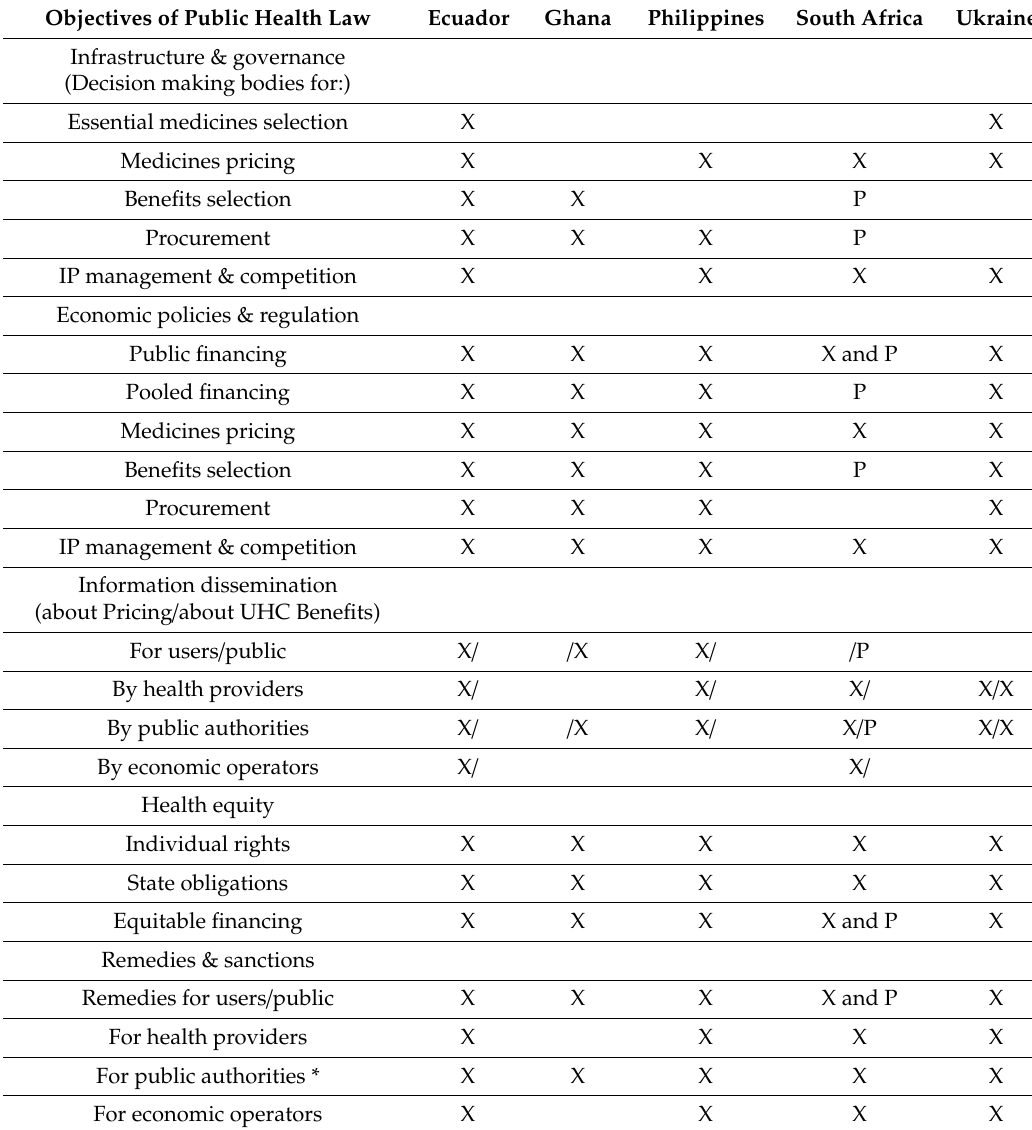
Table 3. Overview of the national laws in five middle-income countries that embed the objectives of public health law for the a ff ordability and financing of medicines. The laws on which this analysis is based are listed in Supplementary Material S3. Legend: X = objective in law. P = objective proposed in draft law. * = includes government o ffi cials and public